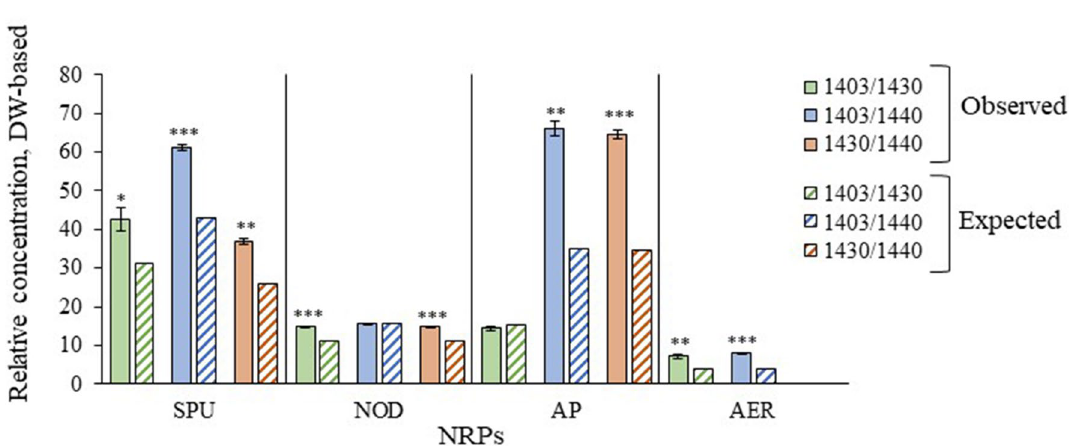
Figure 7. Observed and expected concentrations of total NRPs in N. spumigena co-cultures according to the ConYE model. Total NRPs were pooled by class. NRP classes are denoted as SPU, spumigins; NOD, nodularins; AER, aeruginosins and AP, anabaenopeptins. Only results of dry-weight normalized NRPs concentrations are presented; volume-based results were omitted from the figure due to their similarity with DW-based results. For each NRP class, the significant difference between observed and expected concentrations was tested with one sample t test; *, **, and *** indicates p- value < 0.05, 0.01, and 0.001,